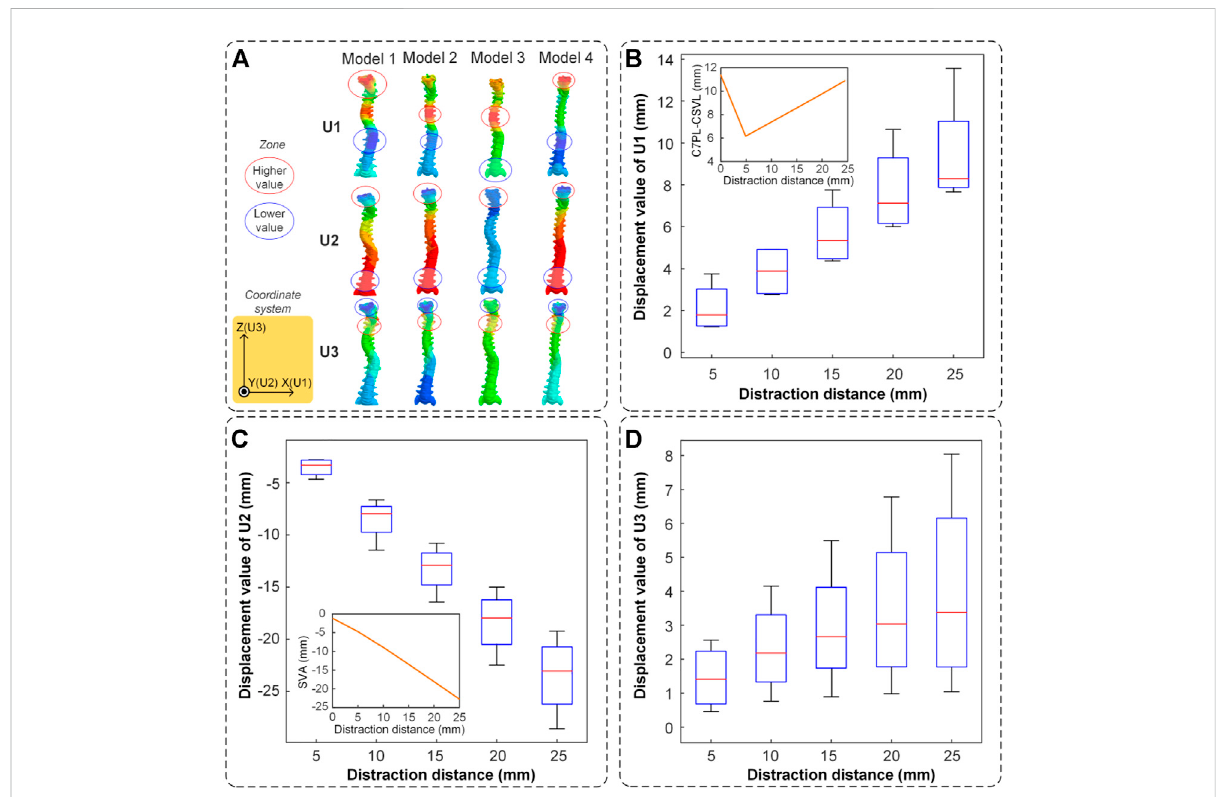
FIGURE 7 The spinal displacement in three directions. (A) The nephogram of fi nite element results (when the distraction distance is 25 mm). The higher valueislabeledinaredcircleandthelowervalueislabeledinabluecircle. (B) ThespinalmaximumdisplacementintheU1direction.Themeanvalue of C7PL-CSVL was measured and displayed in the subgraph. (C) The spinal maximum displacement in the U2 direction. The mean value of SVA was measured and displayed in the subgraph. (D) The spinal maximum displacement in the U3